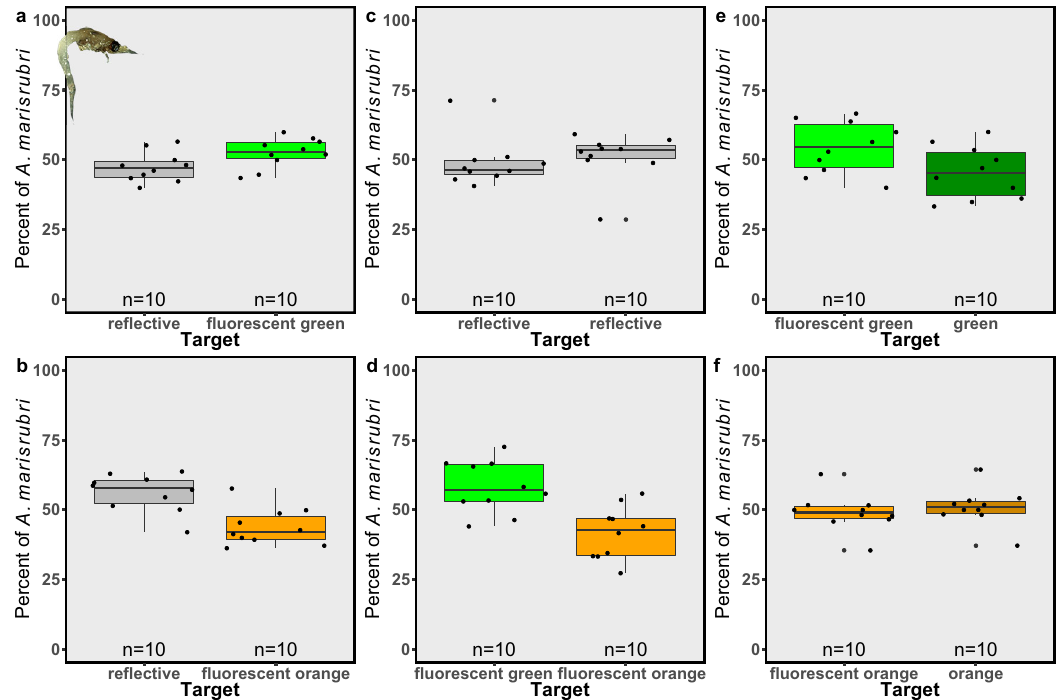
Fig. 2 The attraction of Anisomysis marisrubri ( “ mysids ” ) to fl uorescent and non- fl uorescent targets. Attraction to fl uorescent ( fl uorescent green or fl uorescent orange) or non- fl uorescent (re fl ective, green, and orange) targets presented as the percentage of A. marisrubri attracted to each target. a Re fl ective target (gray boxes) versus fl uorescent green target (bright green boxes), b re fl ective target versus fl uorescent orange target (bright orange boxes), c re fl ective target versus re fl ective target, d fl uorescent green target versus fl uorescent orange target, e fl uorescent green target versus a non- fl uorescent green target (dark green boxes), and f fl uorescent orange target versus non- fl uorescent orange target (dark orange boxes). n = 10 trials for each combination. Boxes represent the upper and lower quartile, centerlines represent medians, and whiskers extend to data measurements that are less than 1.5*IQR away from the fi rst/third